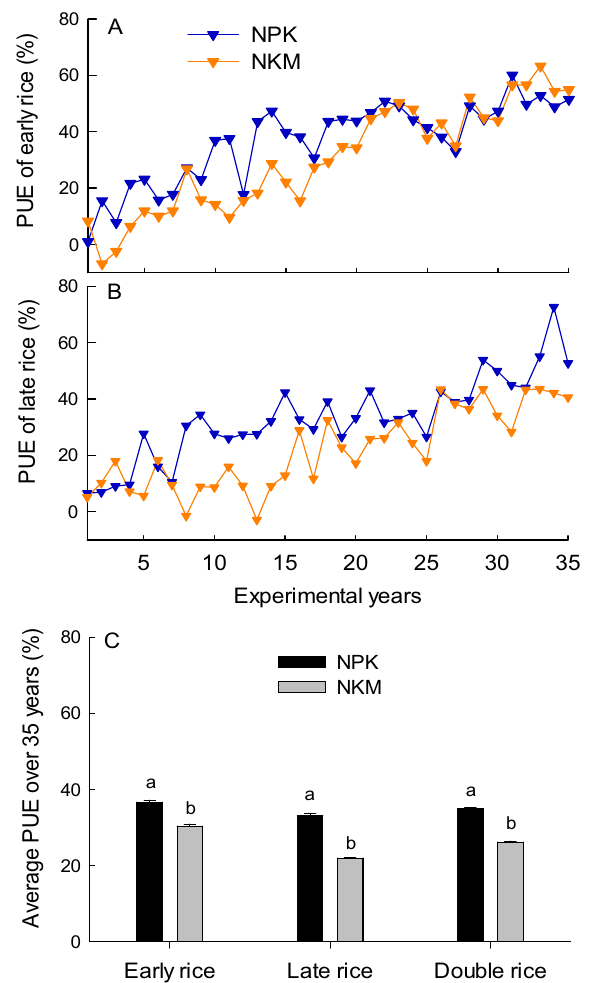
Figure 4. Variation of P use efficiency (PUE) for early ( A ) and late rice ( B ), and the average PUE ( C ) under NPK and NKM fertilization treatments across 35 years. Error bars are standard error of three replicates, and different lower case letters indicate significant differences between treatments at p < 0.05 in ( C